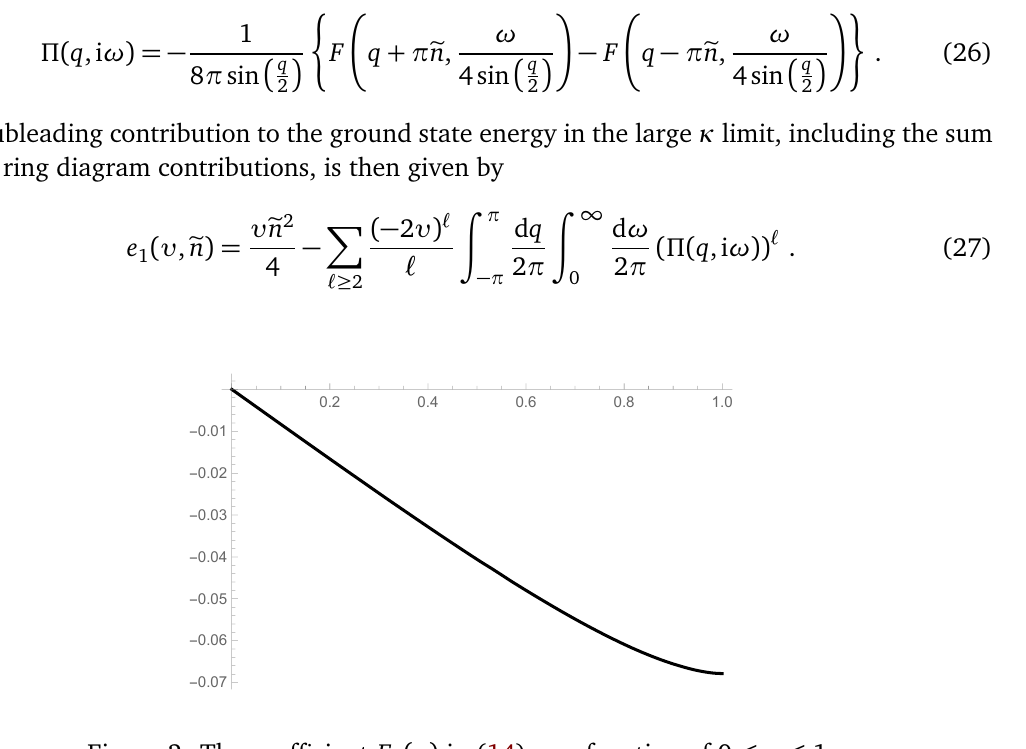
Figure 2: The coefficient E